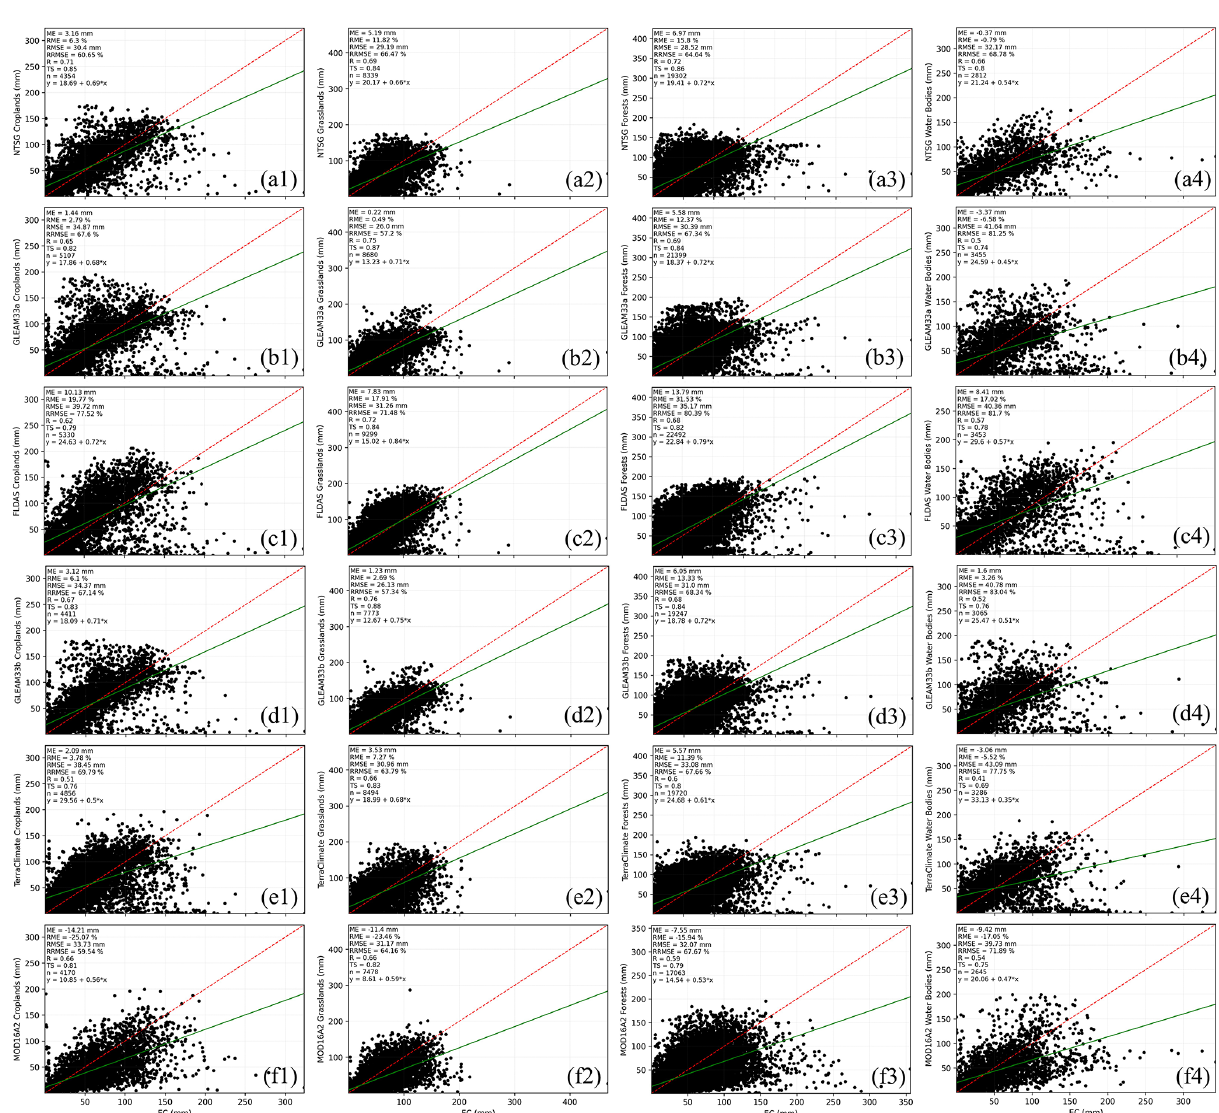
Figure 8. Monthly ET products (NTSG: a ; GLEAM33a: b ; FLDAS: c ; GLEAM33b: d ; TerraClimate: e ; MOD16A2: f ) against flux EC ET aggregated for all sites for each land cover type (croplands: 1; grasslands: 2; forests: 3; water bodies: